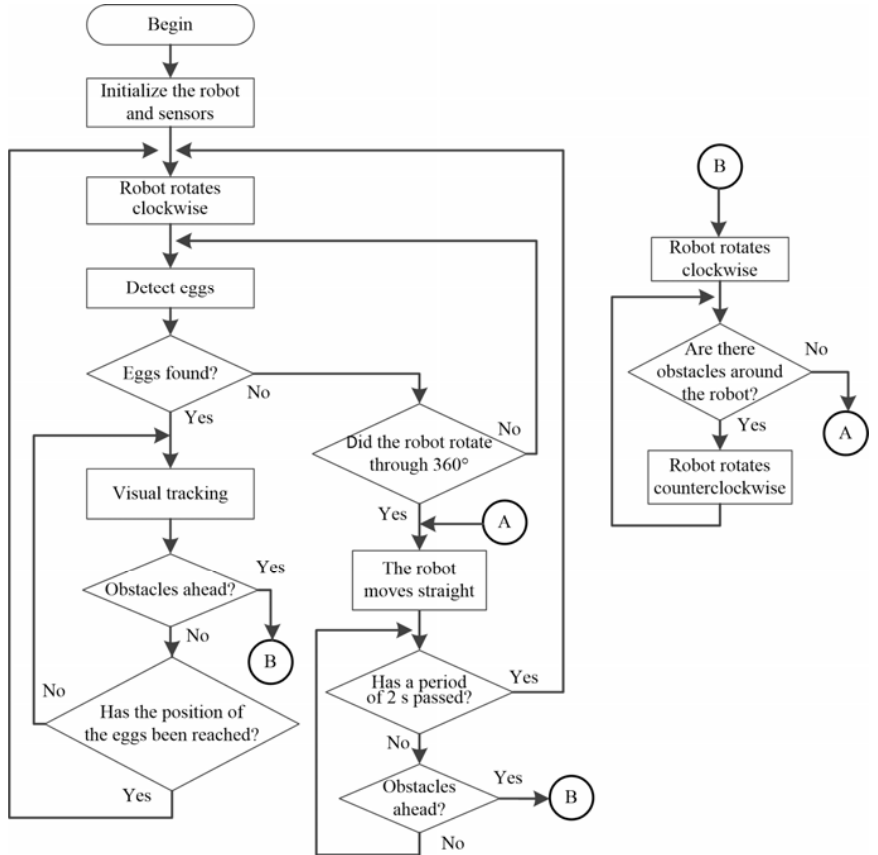
Figure 5. Flow chart for the behavior of the robot.